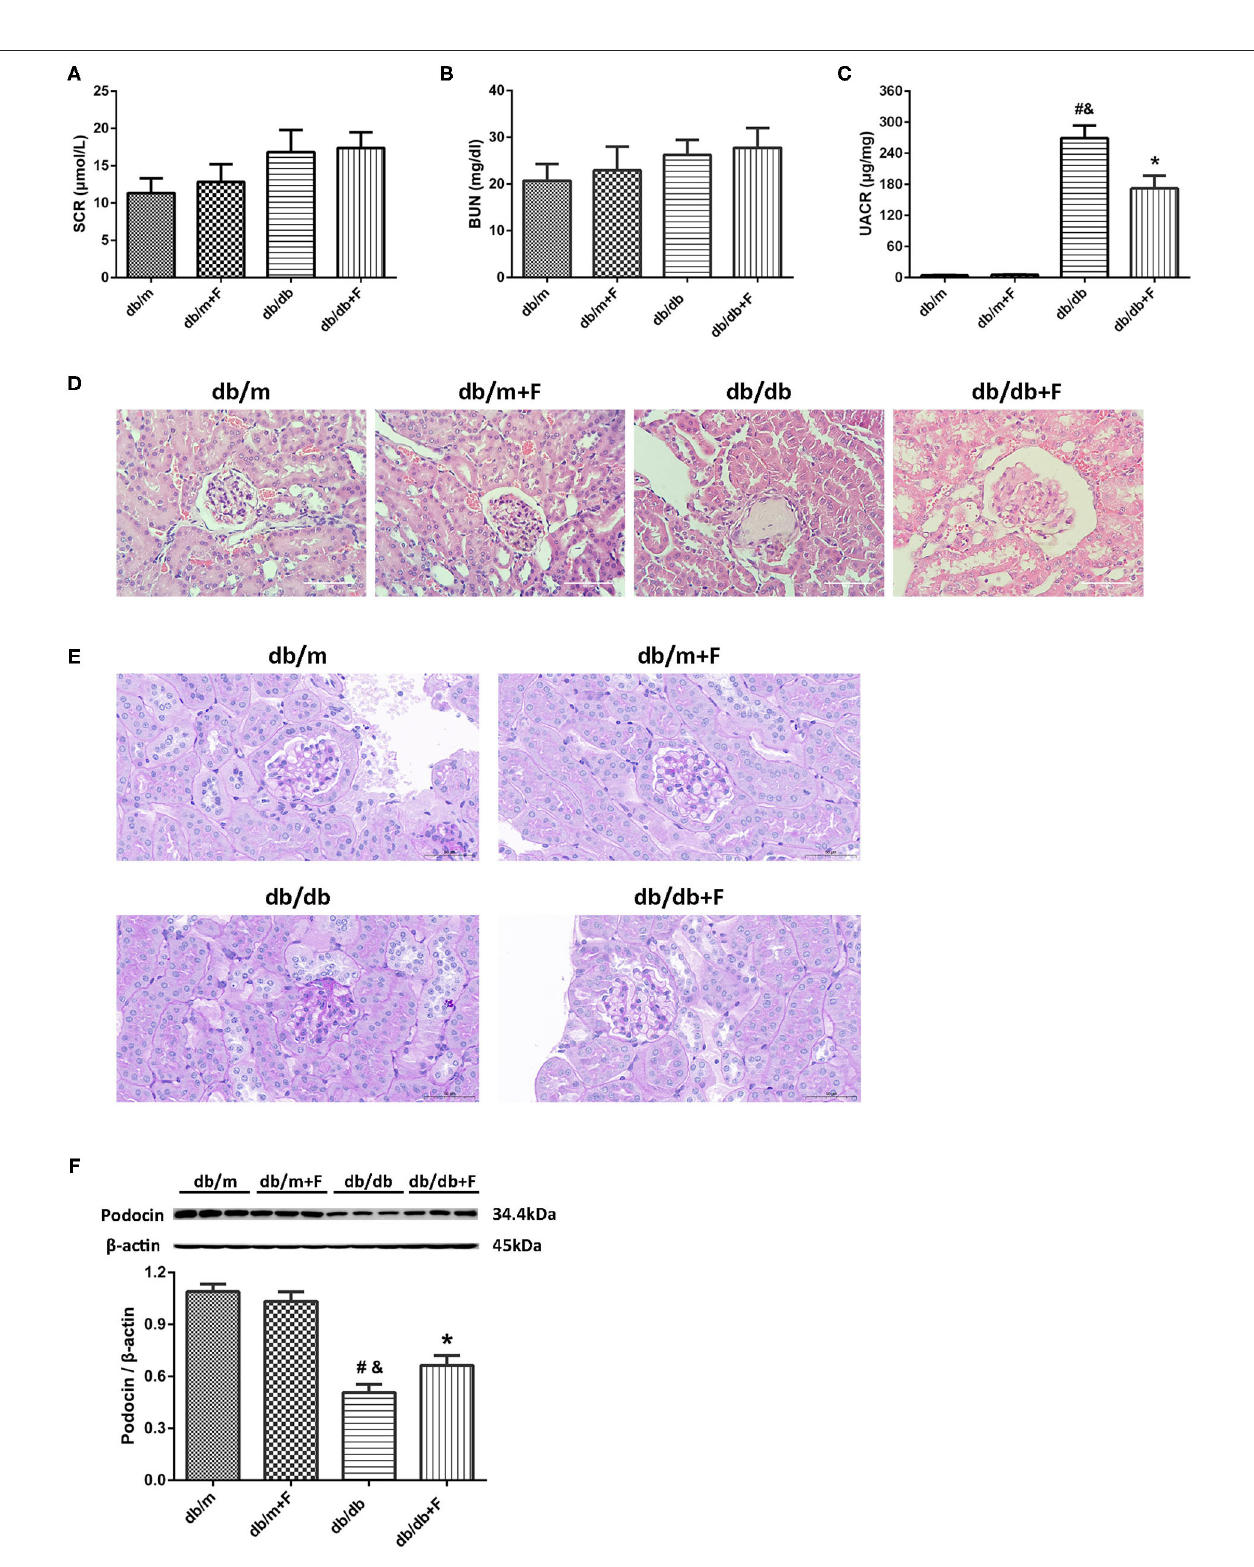
FIGURE 2 | Renal phenotype in db/m, db/m + F, db/db, and db/db + F groups. (A) Serum creatinine (SCr). (B) Blood urea nitrogen (BUN). (C) Urinary albumin-to-creatinine ratio (UACR). (D) Representative photographs of mouse kidneys by H&E staining. (E) Representative photographs of mouse kidneys by